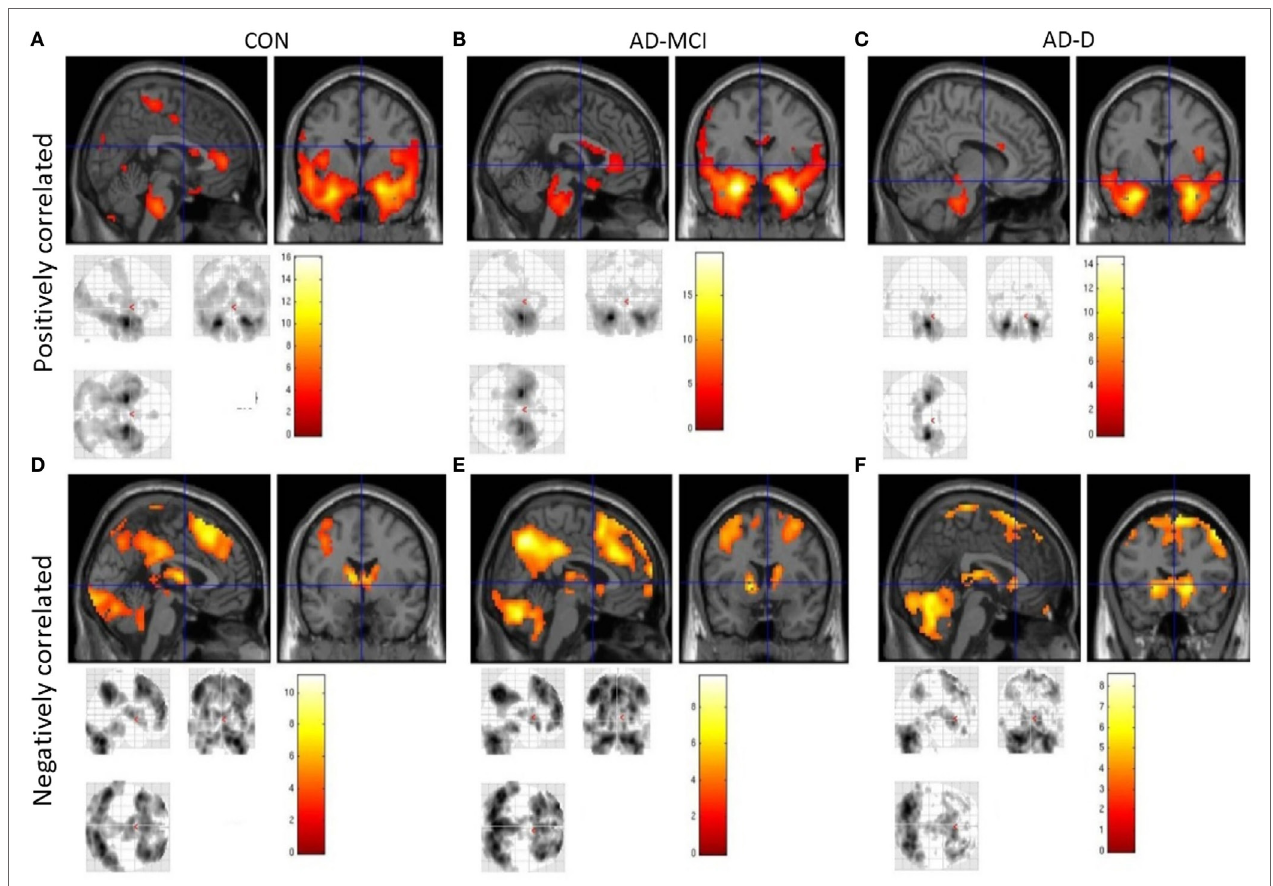
FigUre 2 | intrinsic whole-brain functional connectivity patterns of amygdala across healthy controls (cOn), patients with mild cognitive impairment due to alzheimer’s disease (aD-Mci) and patients with dementia due to alzheimer’s disease (aD-D) . Images (a–c) show positively correlated activity across groups; images (D–F) show negatively correlated activity across groups as labeled. Displayed are clusters larger than 20 voxels, bars represent T -values, p < 0.05, FWE corrected. Abbreviations: CON, healthy controls; AD-MCI, patients with mild cognitive impairment due to Alzheimer’s disease; AD-D, patients with dementia due to Alzheimer’s